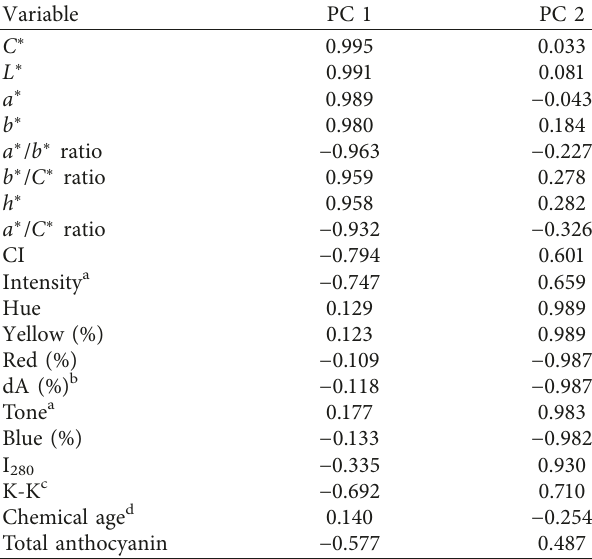
Table 12: Contribution of the variables to each principal com- ponent for the analyzed